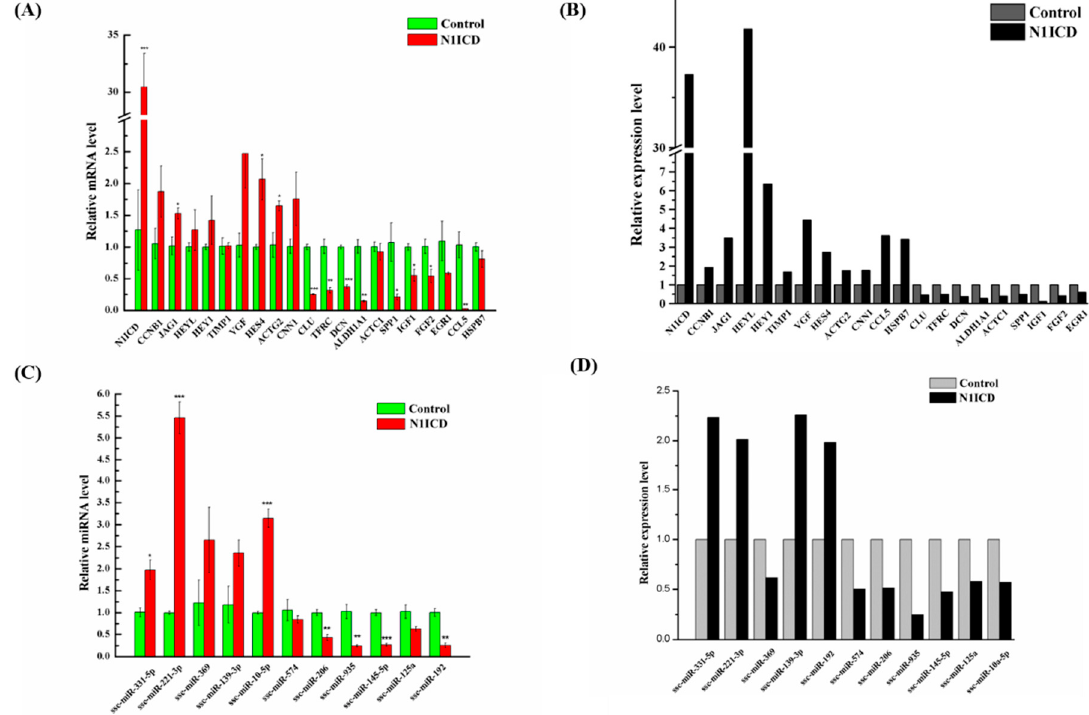
Figure 6. Quantitative RT-PCR validation. ( A ) Quantitative RT-PCR validated DEGs. DEGs (N1ICD, G2/mitotic-specific cyclin-B1 (CCNB1), Jagged 1 (JAG1), HEYL, HEY1, TIMP metallopeptidase inhibitor 1 (TIMP1), VGF nerve growth factor inducible (VGF), HES4, clusterin (CLU), transferrin receptor (TFRC), decorin (DCN), aldehyde dehydrogenase 1 family member A1 (ALDH1A1), actin, alpha, cardiac muscle 1 (ACTC1), secreted phosphoprotein 1 (SPP1), fibroblast growth factor 2 (FGF2)